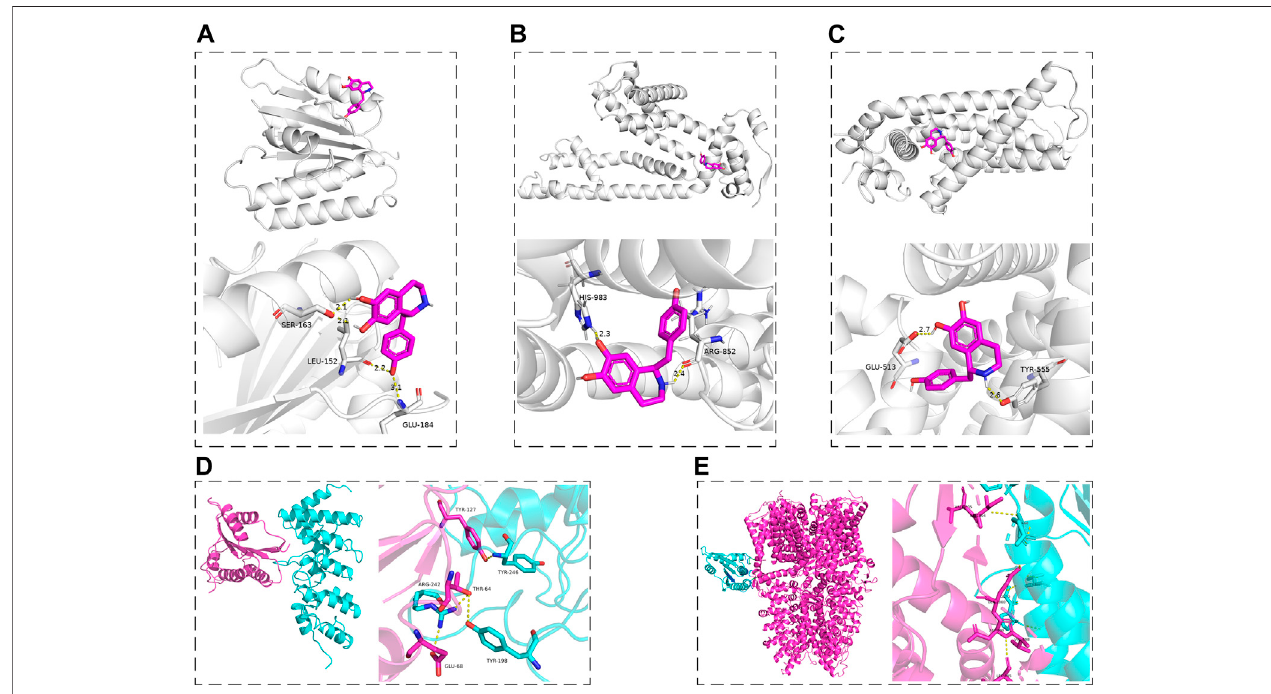
FIGURE 10 | The molecular docking maps. (A – C) The three-dimensional structure of Hig combined with Nox2, TRPA1, and TRPV1, respectively. (D, E) The schematic diagram of the optimal complex in Nox2-TRPV1 and Nox2-TRPA1 protein docking. The dashed line indicated the hydrogen bond formed between Hig and amino acid residues and the length of the hydrogen bond.